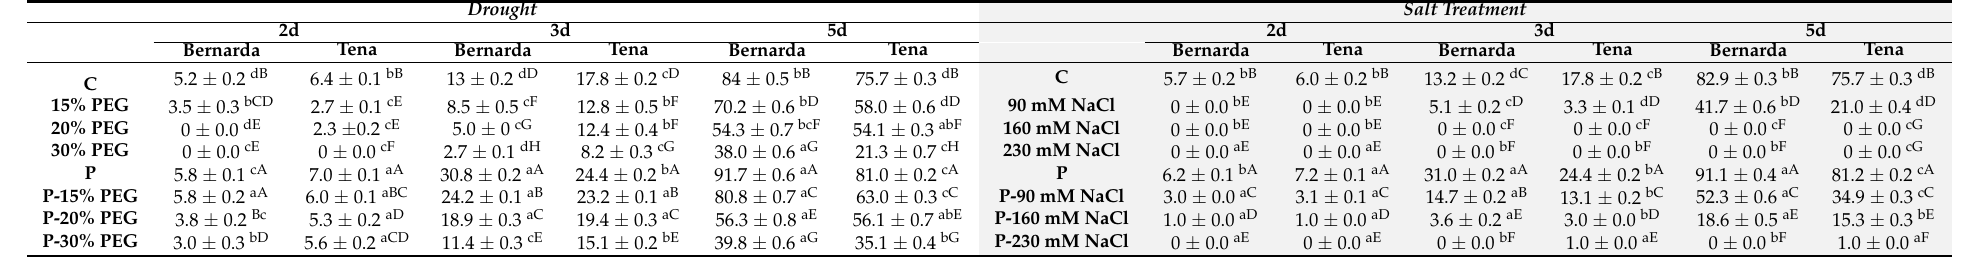
Table 4. Shoot length (mm) of two wheat genotypes at 2, 3 and 5 days of growth under control (C), drought treatments (15%, 20% and 30% PEG), salt treatments (90, 160 and 230 mM NaCl), high voltage electrical discharge (HVED) pretreatment (P) and combined (P-15% PEG, P-20% PEG, P-30% PEG, P-90 mM NaCl, P-160 mM NaCl and P-230 mM NaCl) treatments. Values are means of three repetitions (10 plants/repetition) ± S.D. The different capital letters indicate significances among means of different treatments within the same genotype, while lowercase letters indicate significances among means between genotypes under the same treatment at p < 0.05 using LSD post-hoc test.